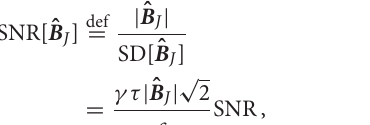
Figure 2C shows the results after